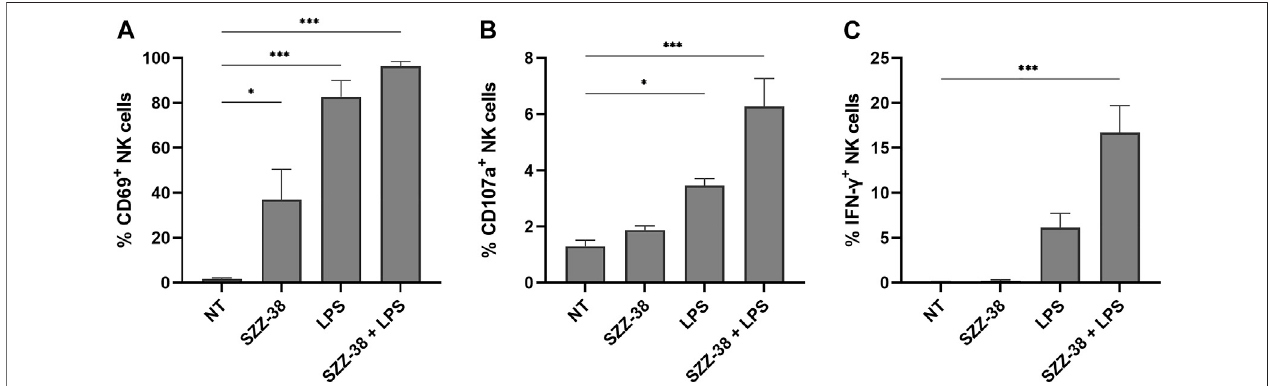
FIGURE 7 | NK cell activation, degranulation, and IFN- γ production in response to NOD1 (SZZ-38, 1 µM) and TLR4 co-stimulation (LPS, 1 µg/mL). Live CD3 − / CD56 + cells were gated as NK cells. Cell surface expression of CD69 (A) and CD107a (B) , and the percentage of IFN- γ producing (C) NK cells were assessed by cell surfaceand intracellular staining,followedby fl owcytometric analysis.Theresultsareexpressedaspercentages ofCD69 + (A) ,CD107a + (B) ,orIFN- γ + (C) CD3 − CD56 + cells.Thedatarepresentthemeans±SEMofthreeindependentexperiments.Statisticalsigni fi cancewasdeterminedbyDunnet ’ smultiplecomparisonstest;*, p < 0.05, ***, p <